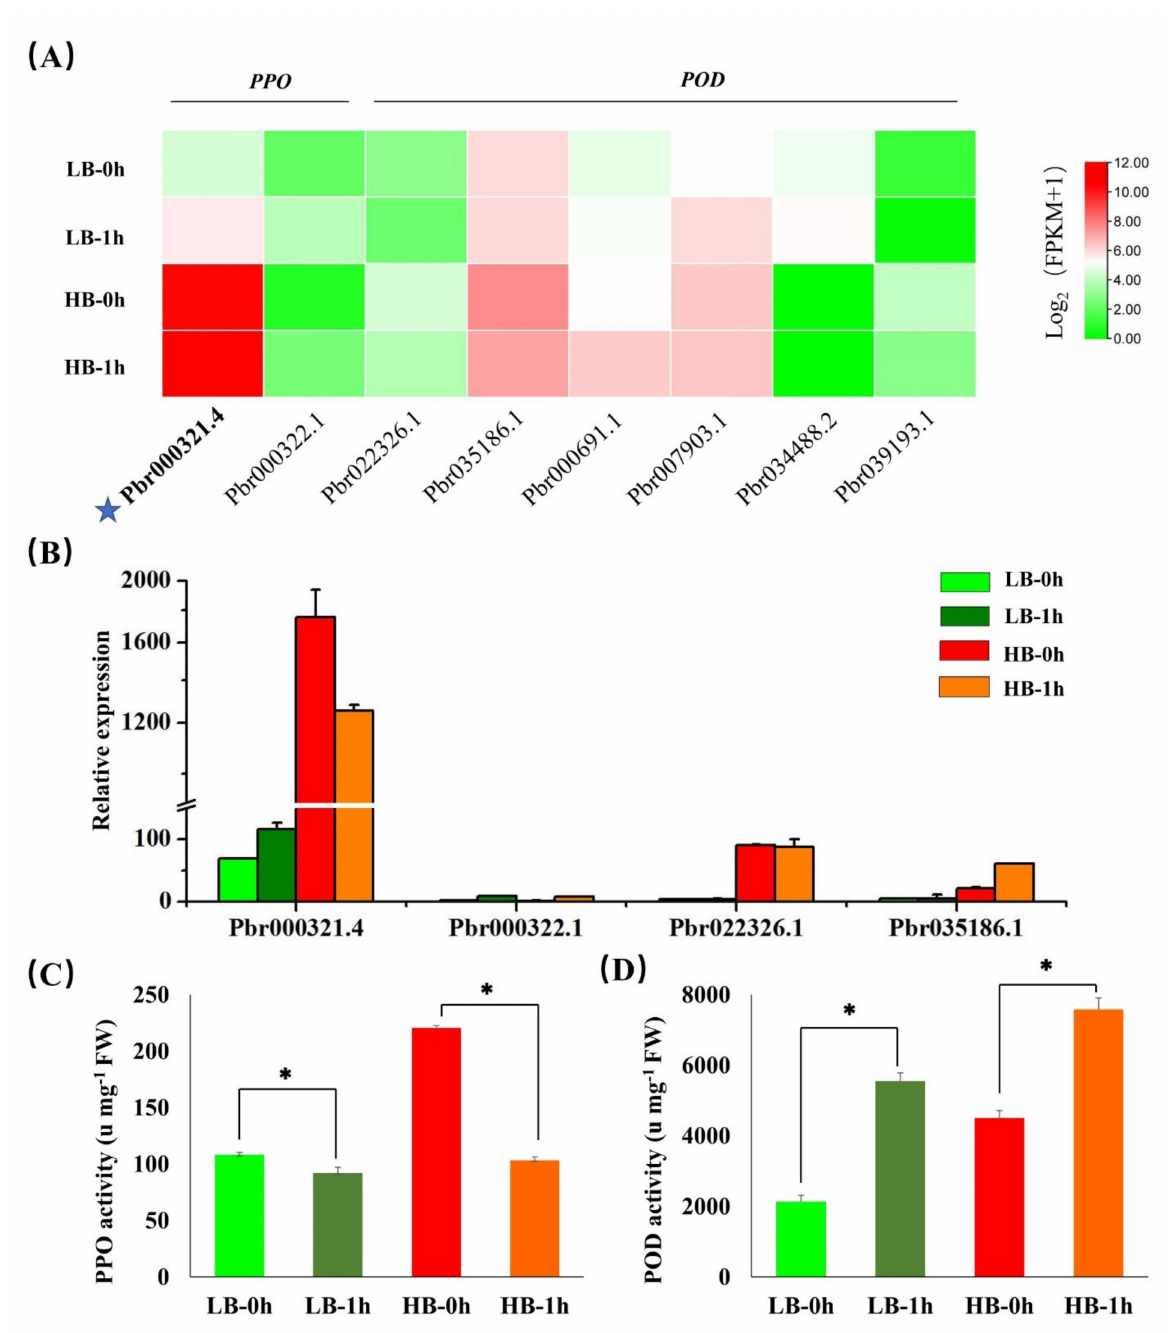
Figure 6. Expression and enzyme activities of polyphenol oxidase (PPO) and peroxidase (POD). ( A ) Heat map depicting Log 2 (FPKM + 1) values for PPO and POD of LB and HB at 0 h and 1 h. ( B ) Relative expression of PPO and POD in two sand pear cultivars at 0 h and 1 h by qRT-PCR analysis. ( C , D ) PPO ( C ) and POD ( D ) enzymes activities in LB and HB at 0 h and 1 h. LB: Low browning cultivar, HB: high browning cultivar; * indicates statistical significance ( p < 0.05), ns: no